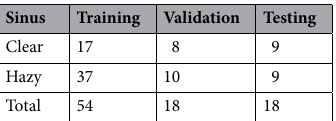
Table 1. Number of maxillary sinuses in the